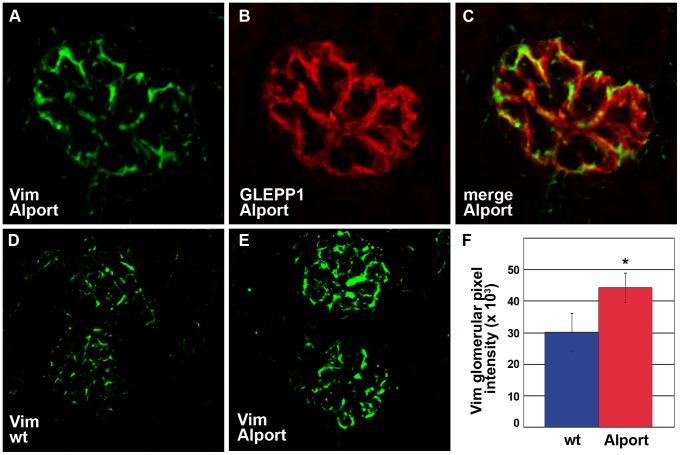
Vimentin is upregulated in podocytes of Alport glomeruli.A–C: Fresh frozen kidney sections from Alport mice were labeled with a combination of goat anti-vimentin and rabbit anti-GLEPP1 IgGs, followed by the appropriate species-specific Alexa Fluor secondaries. Vimentin labeling (A) is restricted to the epithelial podocyte layer, marked by GLEPP1 staining (B), overlap of staining is shown in C (merge). D–F: Representative fluorescence micrographs are shown of anti-vimentin labeling (Vim) of wild-type (D, wt), or Alport (E) mouse glomeruli. The relative glomerular fluorescence intensities were measured and averaged for n = 3 mice of each genotype, wildtype (wt, blue) or Alport (red). * p = 0.04.